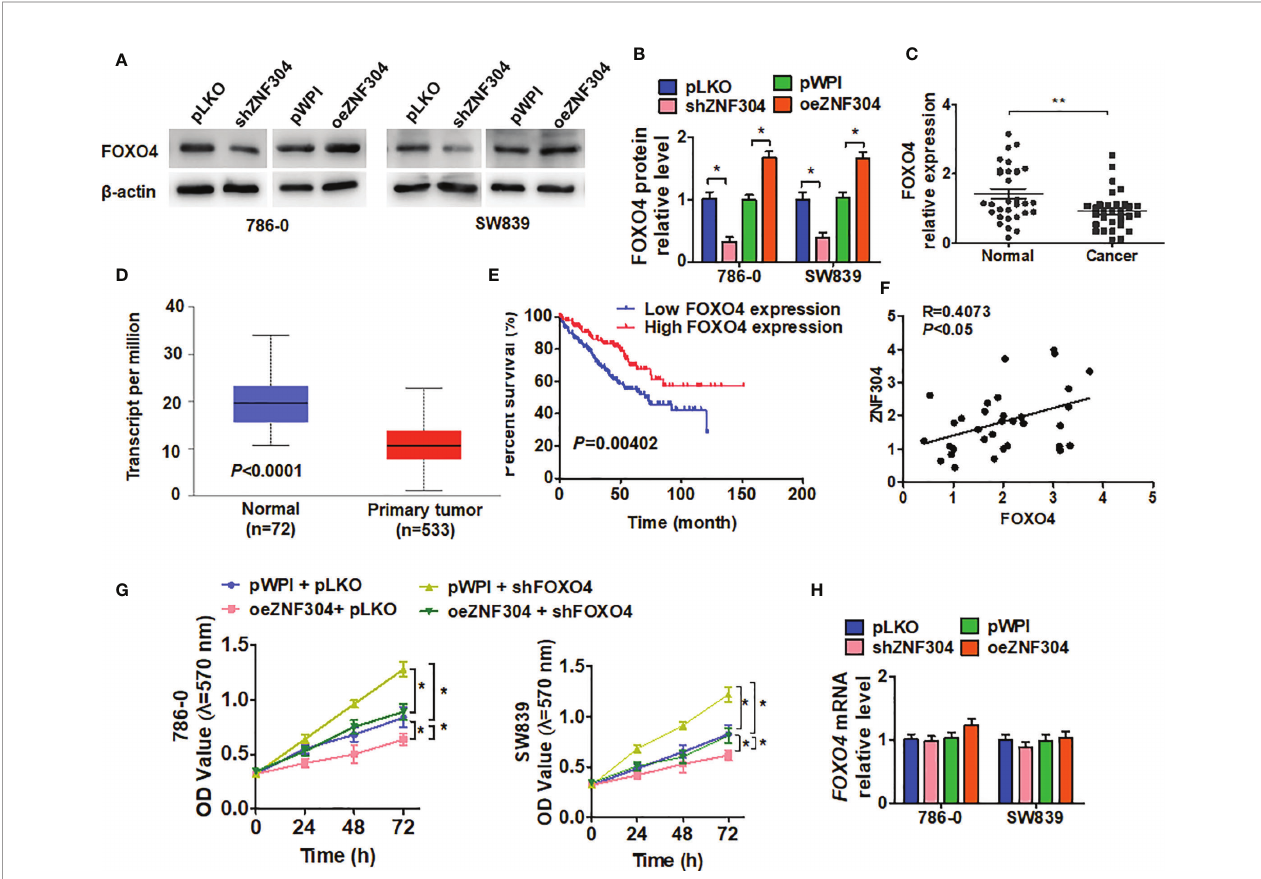
FIGURE 3 | FOXO4 regulates ZNF304-mediated cell proliferation. (A) 786-0 and SW839 cells were transfected with pKLO, shZNF304, pWPI, and oeZNF304 vectors, and then protein expression of FOXO4 was measured by western blot. (B) Quantitative analysis of (A) . (C) The expression of FOXO4 mRNA was measured by qRT-PCR in ccRCC (T, n = 43) and normal kidney (N, n = 43) tissues. (D) the overall survival of ccRCC patients from the TCGA database was analyzed by Kaplan – Meier analysis. FOXO4 levels low (n = 130) and high (n = 130) (cutoff value is 25%). (E) The correlation between ZNF304 and FOXO4 mRNA expression in PCa tissues was analyzed by Pearson correlation analysis of our clinical data (R = 0.4073, P < 0.05). (F) 786-0 and SW839 cells were transfected with oeZNF304, shFOXO4, oeZNF304 + shFOXO4 and control vectors, and cell viability was measured by MTT. (G) Cells were prepared as in (A) , and FOXO4 mRNA was detected by RT-qPCR. (H) Cells were prepared as in (A) , and cell viability was measured by MTT (D) and colony formation assays (E, F) . All data are from three independent experiments and expressed as the mean ± SEM. *P < 0.05, **P < 0.01 vs. the corresponding